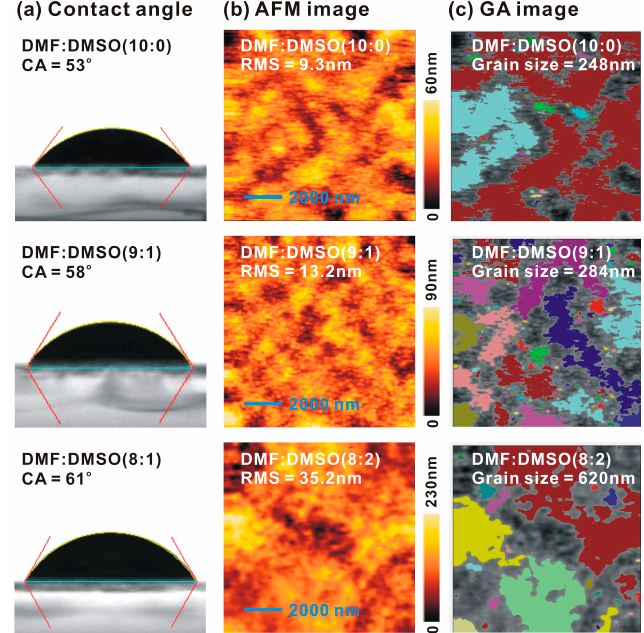
Figure 2. ( a ) Contact angles (CAs) of MAPbI 3 precursor solutions on C 60 /ITO/glass samples; ( b ) Atomic force microscope (AFM) images of the MAPbI 3 /C 60 /ITO/glass samples; ( c ) Graphical analysis (GA) images of the corresponding AMF images. The standard deviations of the contact angles were smaller than 1°.